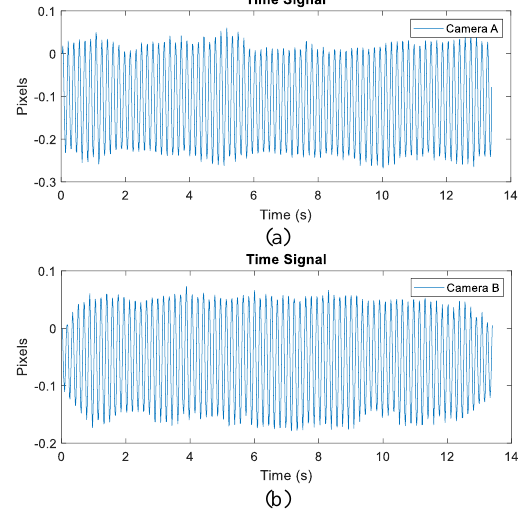
Figure 10. Vibration detection results after noise removal,